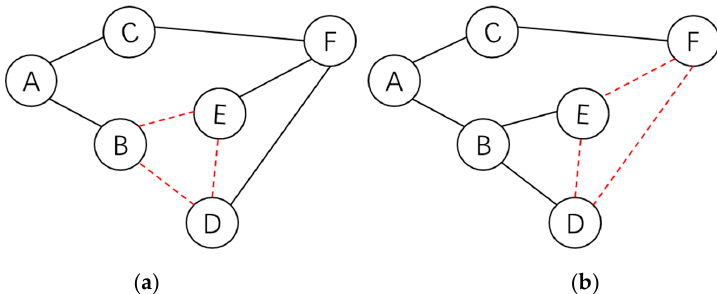
Figure 4. Fundamental cycle set of an undirected graph. ( a ) Fundamental cycle set constructed using depth-first search minimal spanning tree; ( b ) fundamental cycle set constructed using breadth-first search minimal spanning tree. In this figure, black solid lines denote the minimal spanning tree, and the red dotted lines denote missing edges.